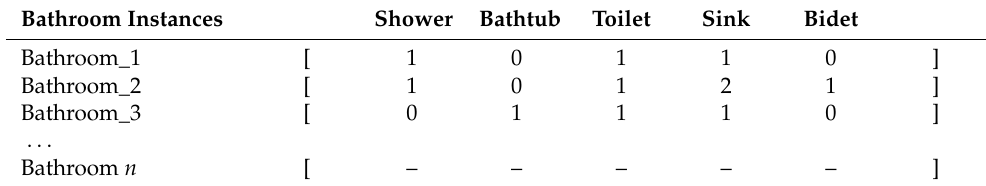
Table 1. Example of the conversion of categorical values into numerical values for